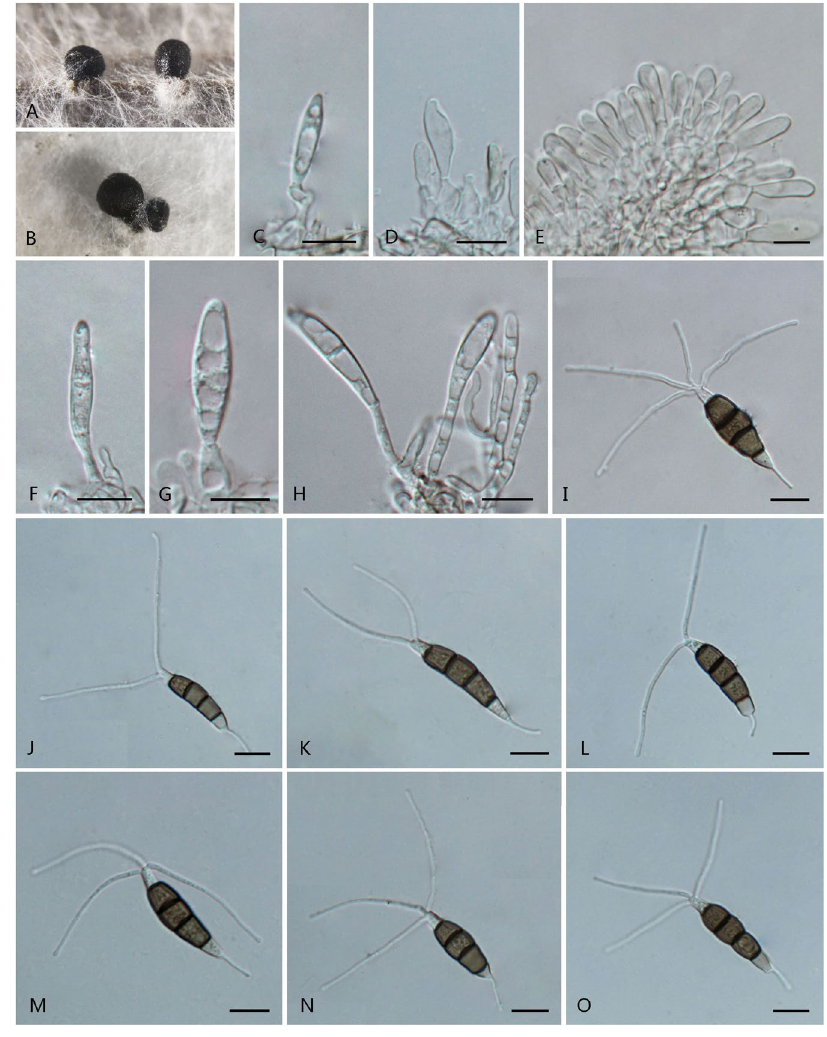
Figure 15. Pseudopestalotiopsis camelliae-sinensis ( A–E , J – O ) from ex-holotype culture CGMCC 3.18155 ( = LC3490), ( F–I) from LC6677. ( A ) Conidiomata sporulating on pine needle. ( B ) Conidiomata sporulating on PDA. ( C–H ) Conidiogenous cells and conidia. ( I–O ) Conidia. Scale bars = 10 μ